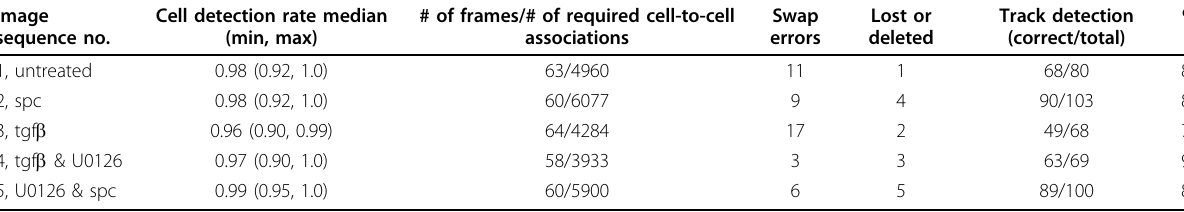
Table 3 Validity of automatically extracted cell tracks Image sequence no.